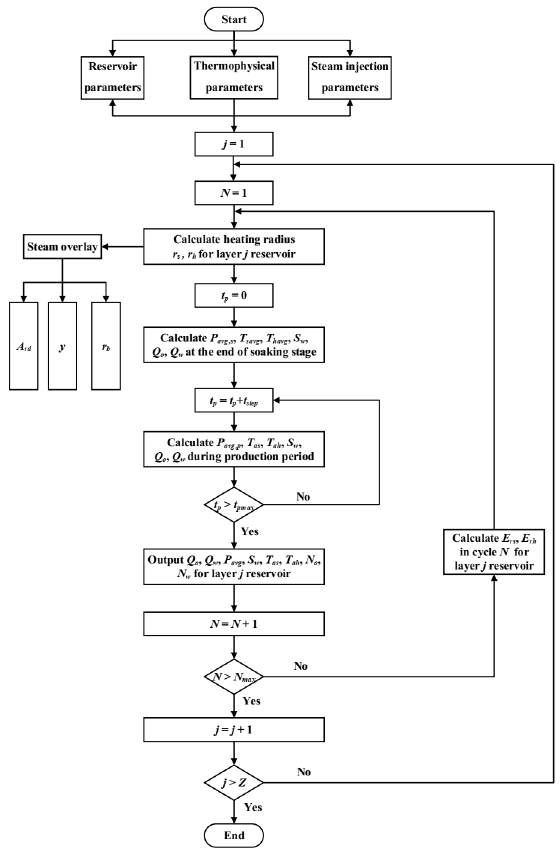
Figure 5. A flowchart for the calculation process of this